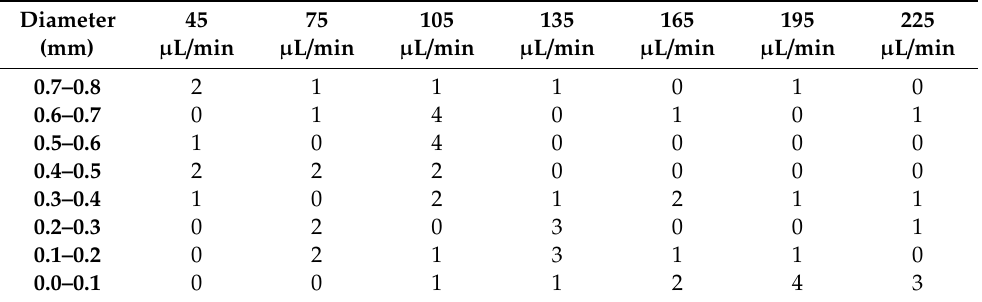
Table 2. Number of beads counted after 30 s. Terms of specific flow rates against specific areas of microfluidic channels at the same time for each test.